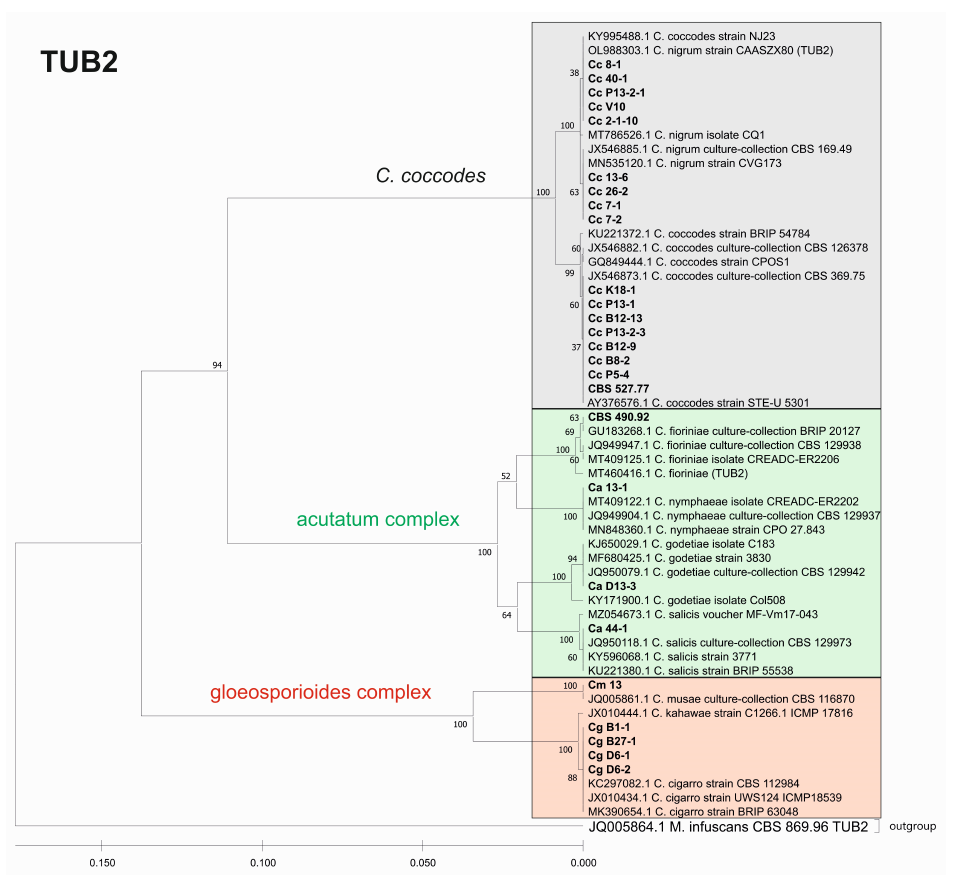
Figure 9. Phylogenetic tree based on TUB2 barcode. Genetic diversity and taxonomic assignment of the studied Colletotrichum isolates against accessions in the NCBI database and assessed by DNA barcode for the beta-tubulin (TUB2) locus. The Colletotrichum clades coccodes, gloeosporioides, and acutatum are depicted by grey, red, and green boxes, respectively. The trees were constructed in MEGA11 using the UPGMA clustering method and the Kimura 2-parameter model. The percentage of replicate trees in which the associated taxa clustered together in the bootstrap test (500 replicates) is shown next to the branches. The tree is drawn to scale, with branch lengths in the same units as those of the evolutionary distances used to infer the phylogenetic tree. All ambiguous positions were removed for each sequence pair (pairwise deletion option). Sequences derived from the NCBI are shown with their accession number and organism